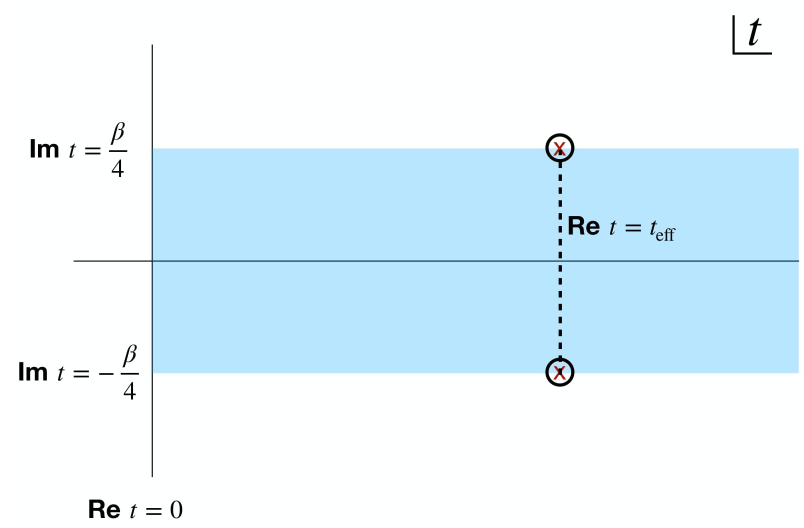
Figure 3 . F ( t ) , as a function of complex t , is analytic in the shaded blue region. However, the extremal OTOC (1.3) has singularities at t = t simple i(cid:15)